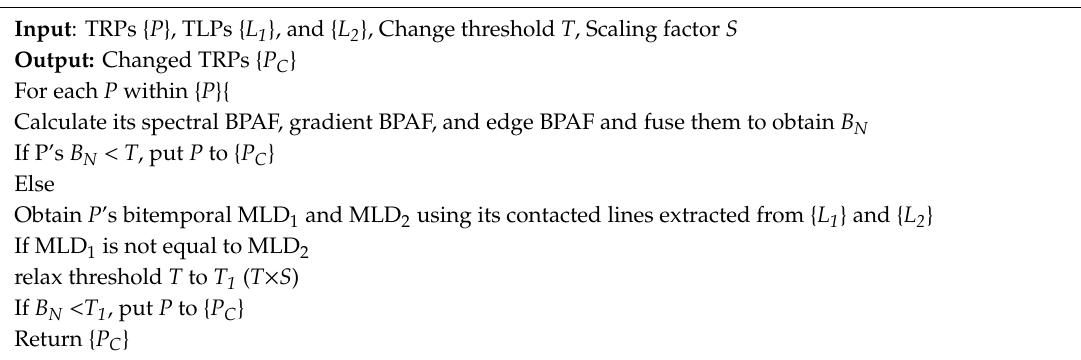
Algorithm 1 . Two-stage change